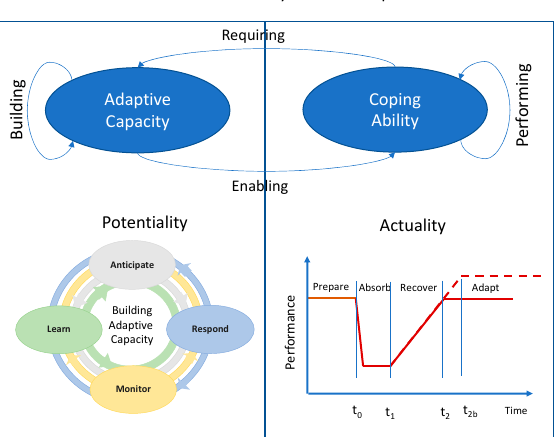
Figure 1. Resilience as a dynamic concept. The adaptive capacity is built through a continuous process where the four resilience cornerstones are implemented. The coping ability is exhibited as soon as an event occur and follows the four phases: prepare, absorb, recover, and